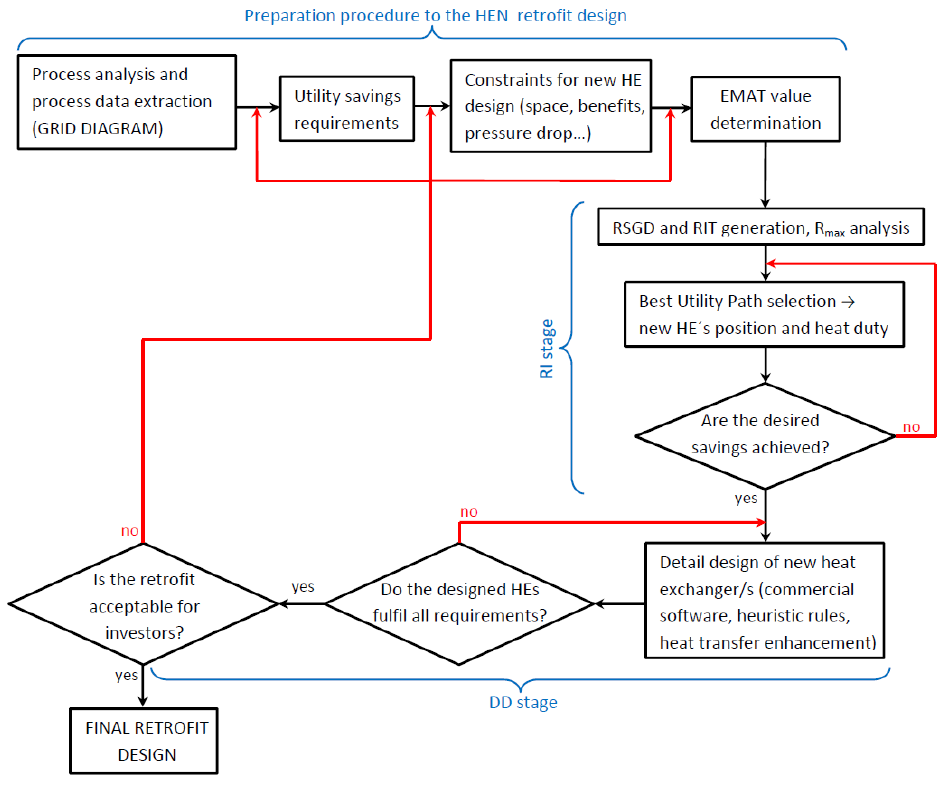
Figure 3. The developed procedure